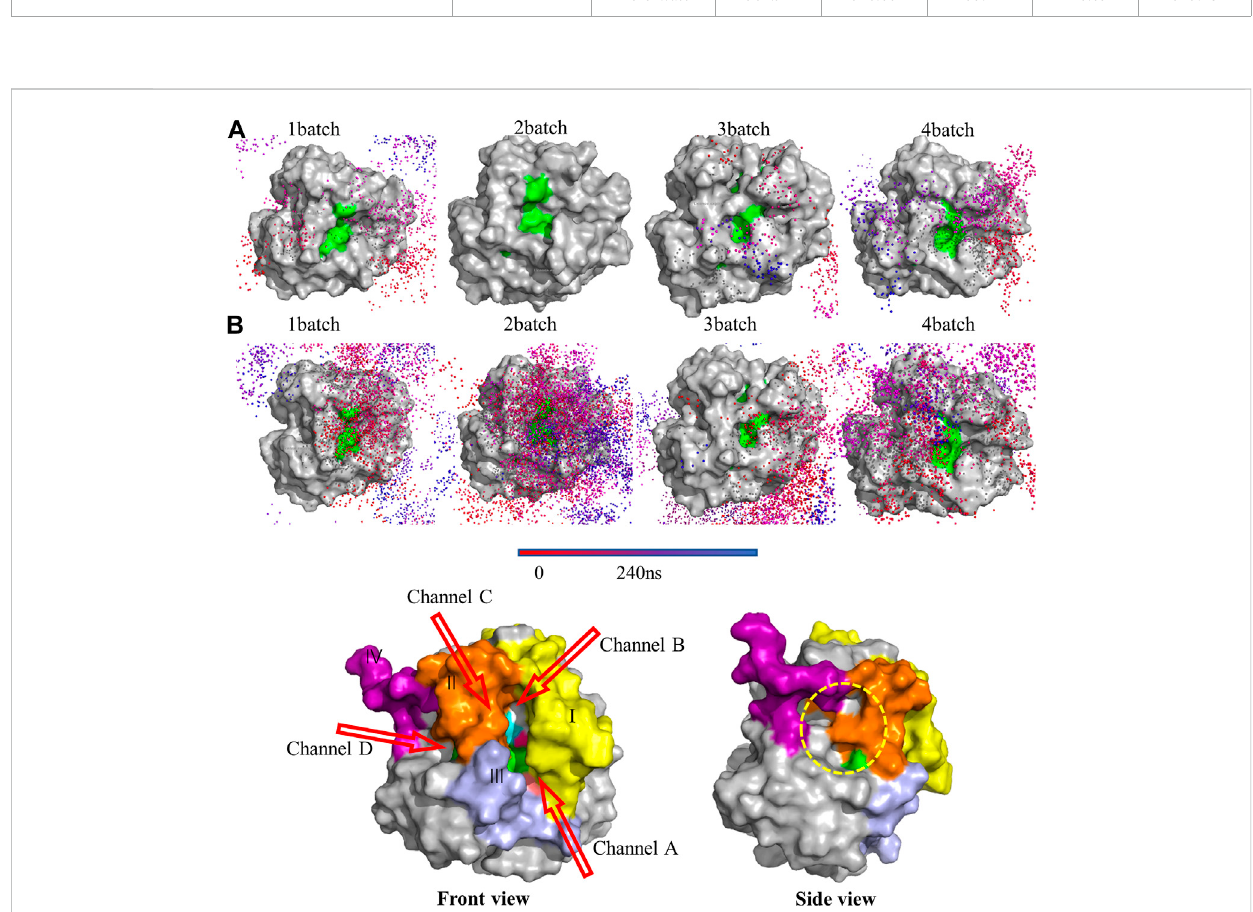
FIGURE 12 Trajectories of the substrates (A) PC; (B) DHA-TAG in solvent-free system with micro-water under 4 MD simulation; Only trajectories of the substrates which could enter the active pocket were shown. Other molecules were hidden for the easier visualization. The catalytic triad residues (S146- D201-H258) were represented as green color to guide the location of the active pocket; (C) The diffusional channels of PLA1. Four main regions with obvious changes were shown by different colors. The catalytic triad residues (S146-D201-H258) were represented as green to guide the active pocket ’ s